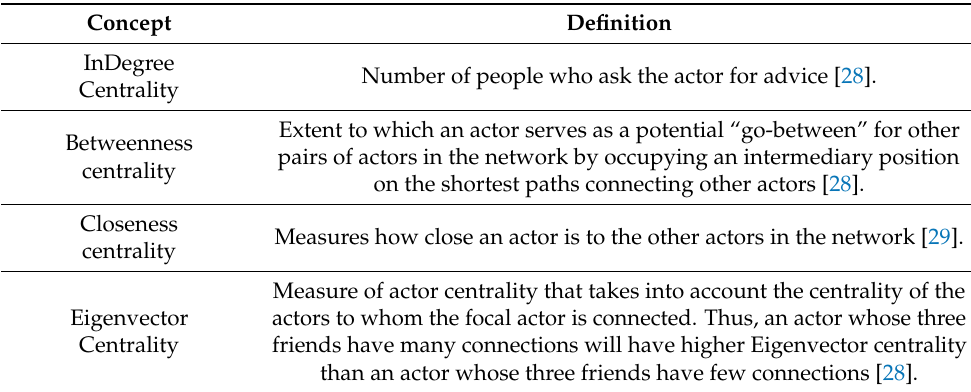
Table 1. Definitions of the Social Network Analysis (SNA) centrality metrics.